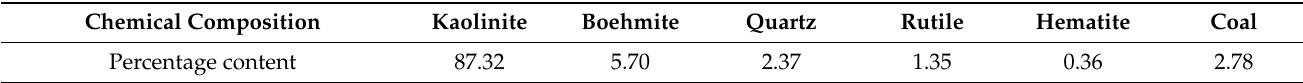
Table 2. Chemical composition of CSK sample (wt.%).